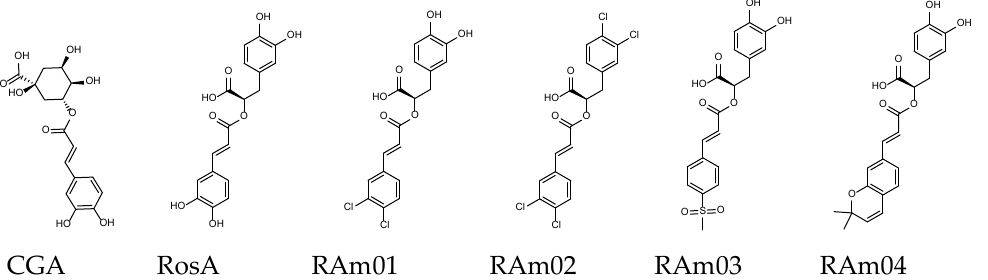
Figure 8. Structures of RosA derivatives. Chlorogenic acid (CCA) is for reference and comparison.